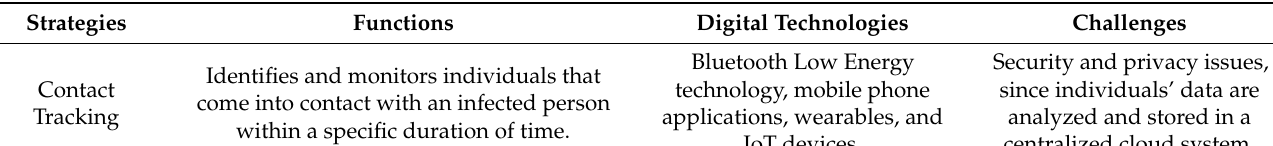
Table 1. Summary of the COVID-19 pandemic’s management and response strategies